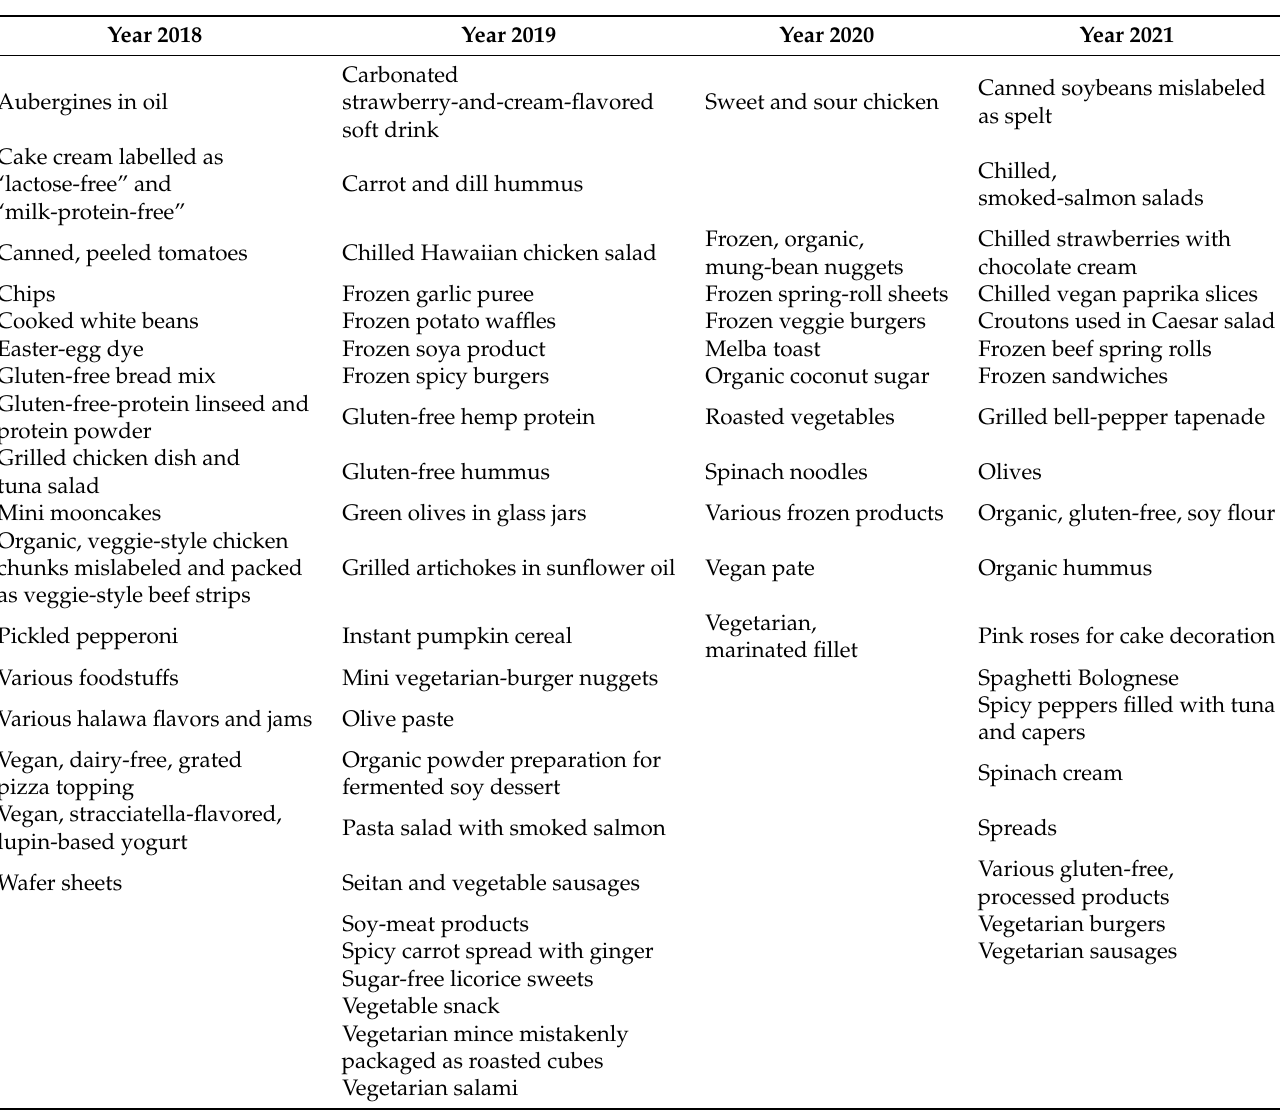
Table A1. Food products involved in “other/mixed products category” in the RASFF